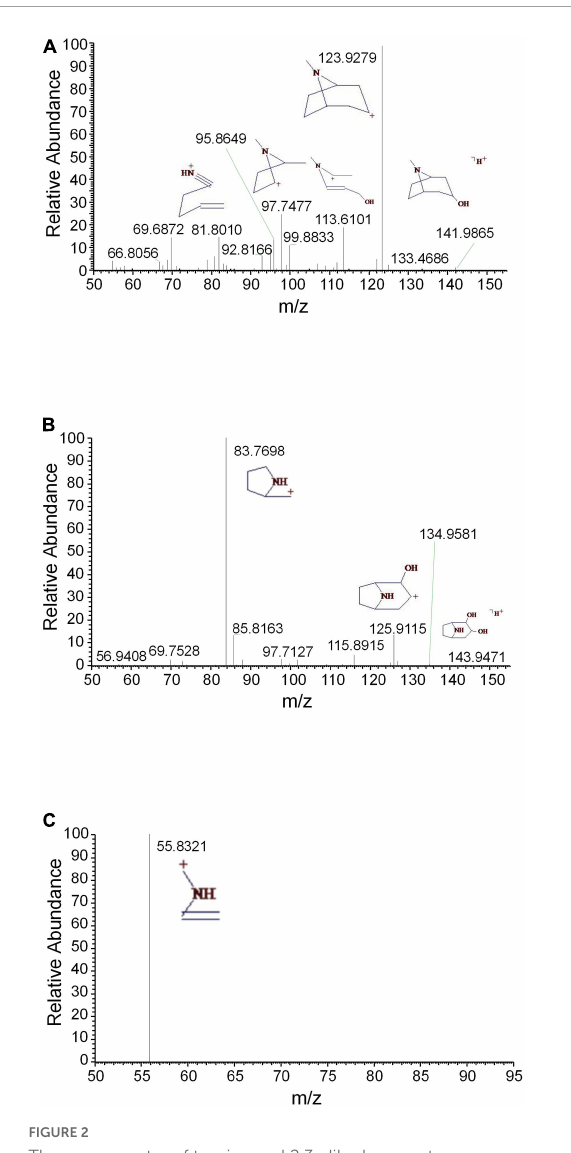
FIGURE2 The mass spectra of tropine and 2,3-dihydroxynortropane. (A) The MS 2 spectrum of tropine, (B) the MS 2 spectrum of 2,3-dihydroxynortropane or an isomer, and (C) the MS 3 spectrum of 2,3-dihydroxynortropane or an